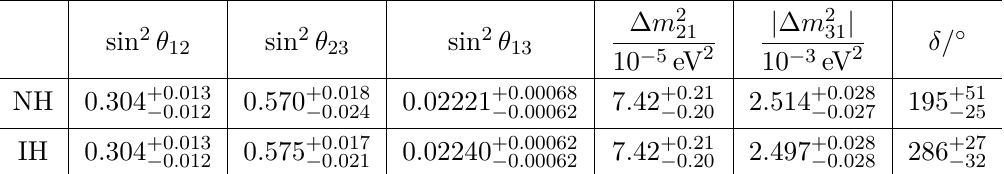
Table 3. The fitted three active-neutrino oscillation parameters taken from ref. [93]. The